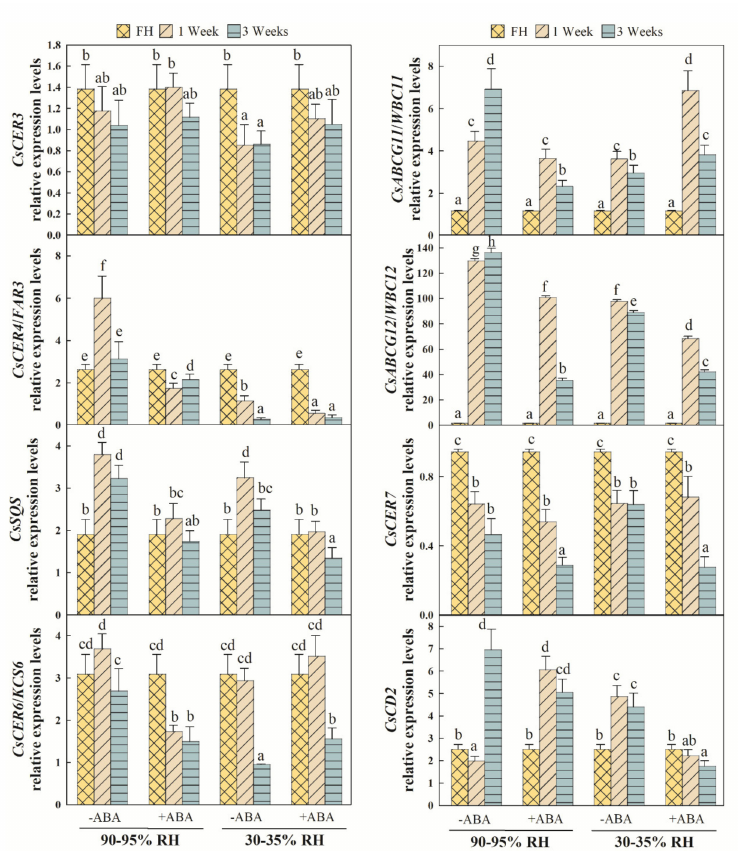
Figure 6. Effect of ABA and water stress on the transcriptional regulation of epicuticular wax metabolism. Relative expression levels of the genes related to the transcriptional ( CsCD2 ) and post- transcriptional ( CsCER7 ) regulation of the biosynthesis ( CsCER6/KCS6 , CsCER3 , CsCER4 and CsSQS ) and transport ( CsABCG11/WBC11 , CsABCG12/WBC12 ) of the wax components in the Pinalate fruit treated (+ABA) or not ( − ABA) with ABA (1 mM), and left at high (90–95%) or low (30–35%) RH for up to 3 weeks at 20 ◦ C. Gene expression values are expressed as fold change levels of all conditions as compared to the freshly harvested (FH) fruit. Values are the means of three biological replicates per condition. Different letters indicate statistical ( p < 0.05) differences among all the conditions together according to an ANOVA analysis followed by a Tukey test ( p < 0.05) for each gene